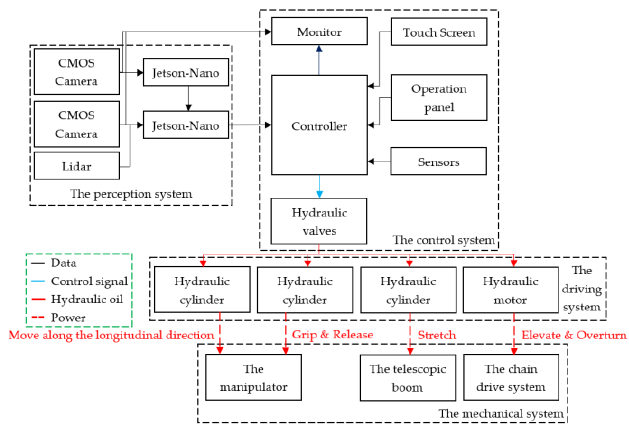
Figure 2. The composition of the trash can-handling robot.